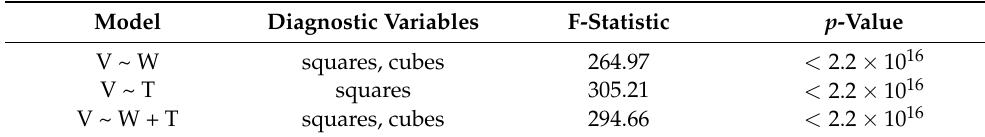
Table A1. The result of Ramsey’s RESET test. Model Diagnostic Variables F-Statistic p -Value V ~ W squares, cubes 264.97 < 2.2 × 10 16 V ~ T squares 305.21 < 2.2 × 10 16 V ~ W + T squares, cubes 294.66 < 2.2 × 10